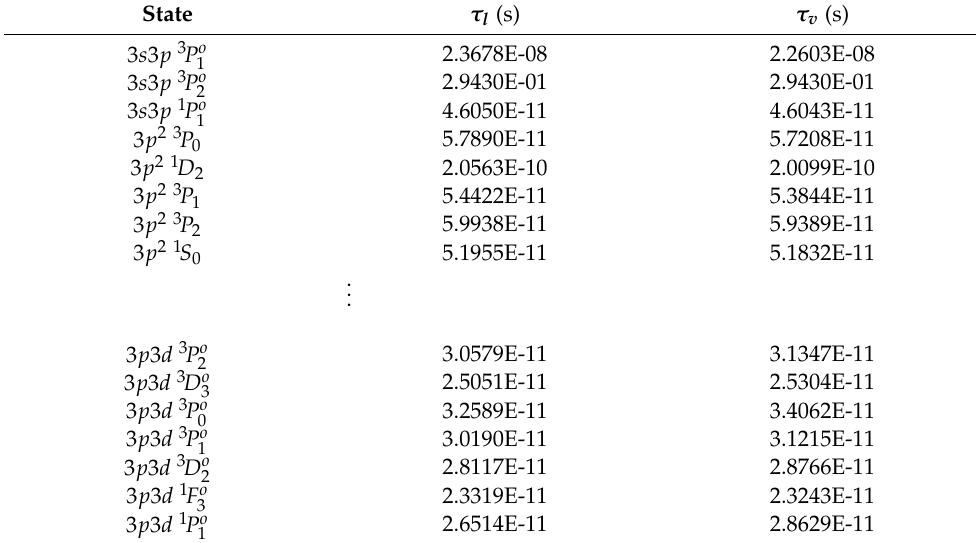
Table 5. Lifetimes in s.